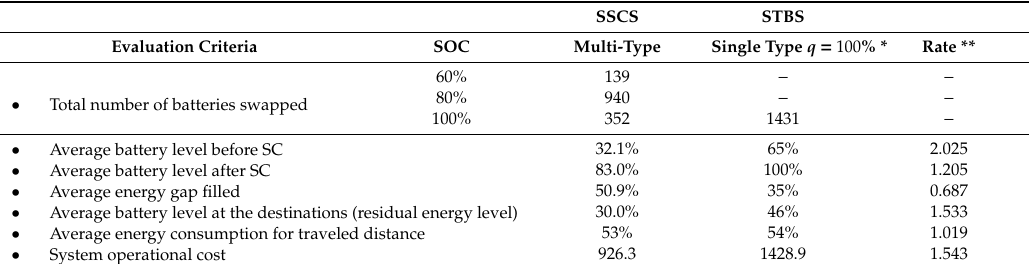
Table 6. Results comparison with the alternative system.